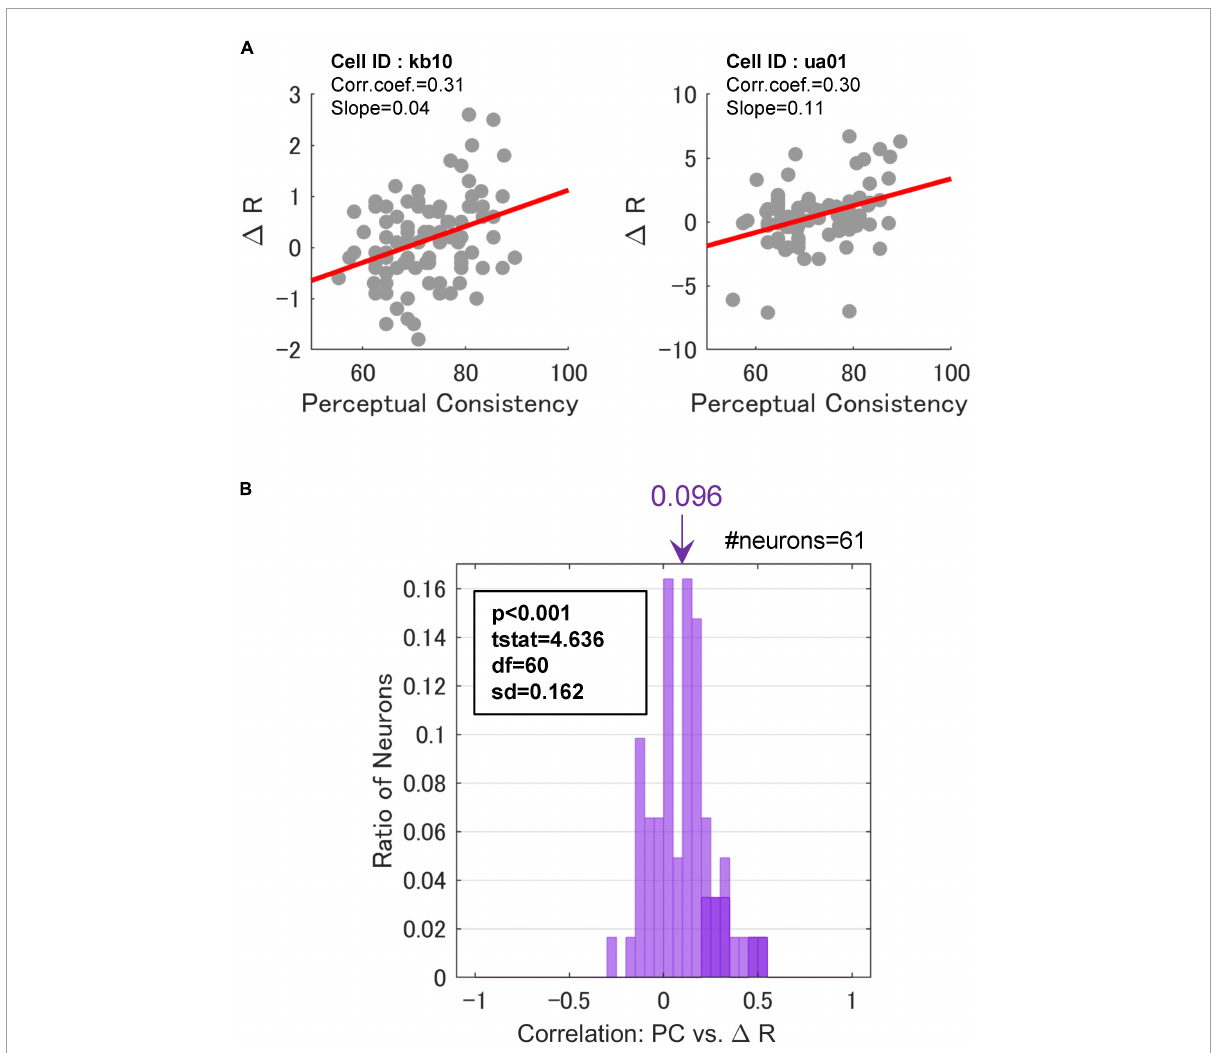
FIGURE6 Correlations between perceptual consistency and (cid:49) R. (A) PC and (cid:52) R in a scatter plot for two example FG neurons. Dots represent individual stimuli. The red lines indicate the linear regression. (B) The distribution of Spearman’s rank correlations between PC and (cid:52) R . The inset indicates the results of a one-sided t -test against 0. Neurons with significant correlations were colored